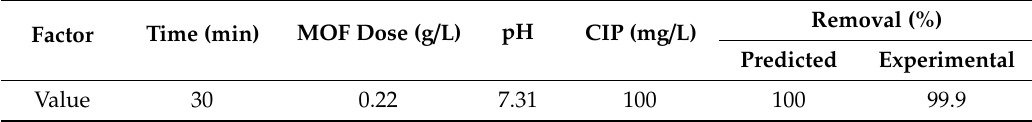
Table 6. Optimum values for each independent variable.